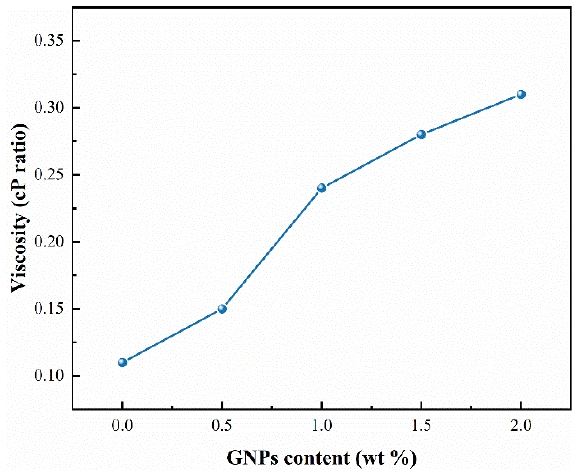
Figure 9. Viscosity of the composites with different contents of GNPs.